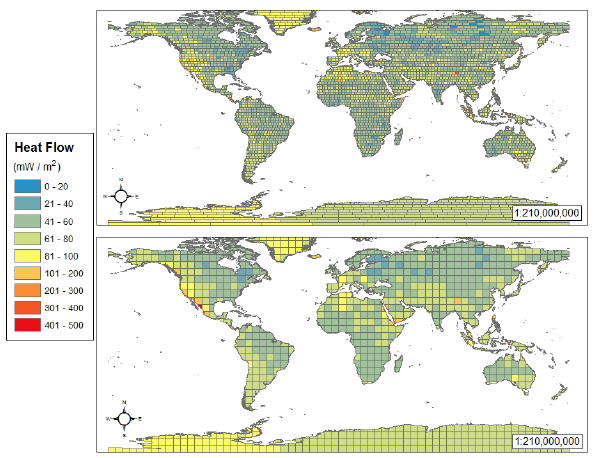
Figure 4. The original geothermal heat flux map (top) from Davies (2013) and the weighted average version (top) for use as the lower boundary value in the i LOVECLIM experiments